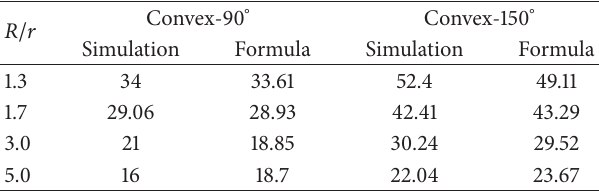
Table 7: The contrasts between the simulation and the